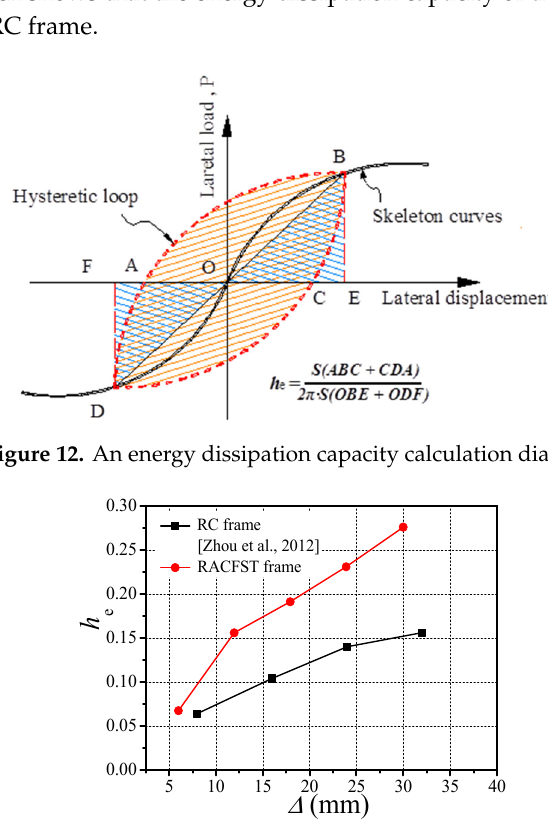
— 4.4. Energy Dissipation Capacity The equivalent damping ratios — those are, h e = S (ABC+CDA) /(2 π · S (OBE+ODF) ), in which S (ABC+CDA) is the area of the hysteresis loop of DABCD, and S (OBE+ODF) is the total area of the triangles of OBE and ODF — for evaluating the energy dissipation capacity calculated from the load – displacement hysteretic loops are shown in Figure 12. The purpose was to reflect the better energy dissipation capacity of the frame proposed in this paper compared with that of the RC frame proposed by Zhou et al. [22]. Figure 13 gives the equivalent damping ratios versus the maximum lateral displacement corresponding to the test frame and the contrasting RC frame. It can be found that the value of h e increases with the increase in lateral displacement, which indicates that more energy is consumed.